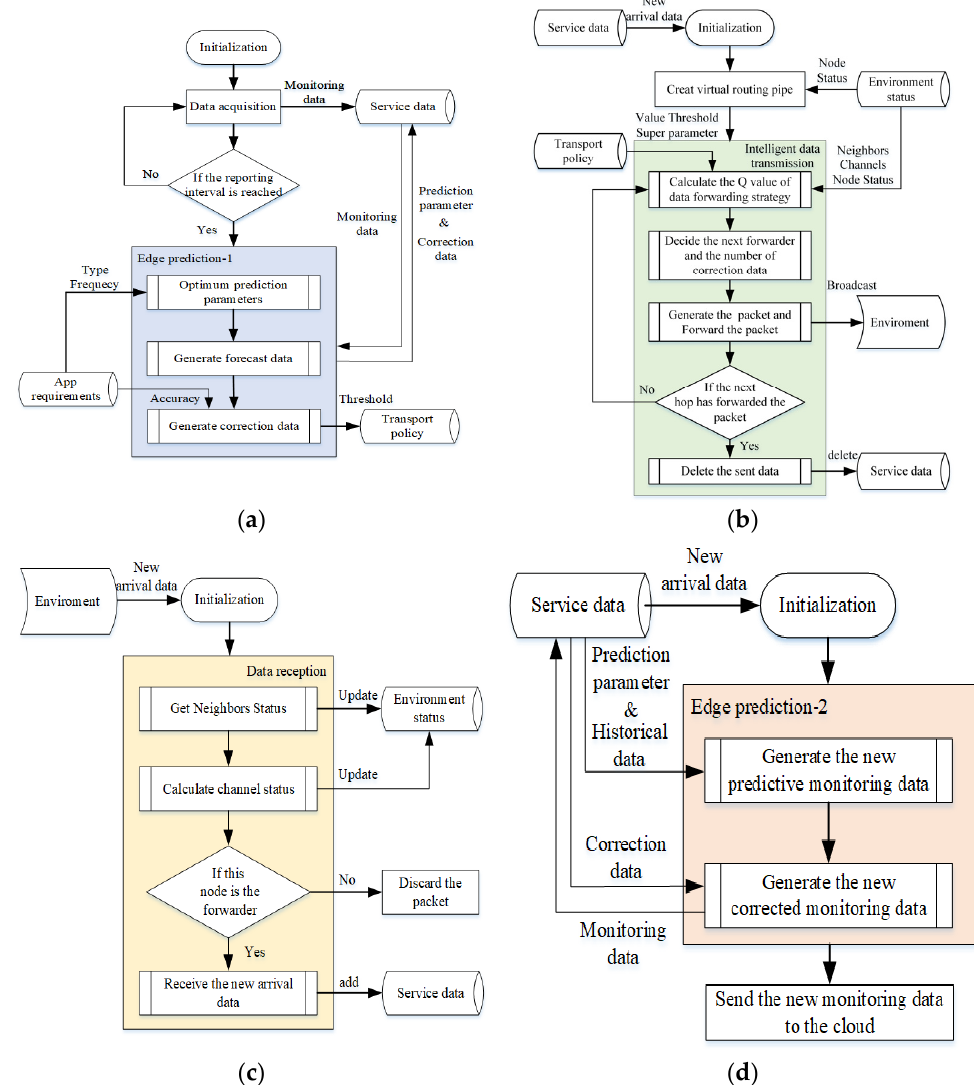
Figure 3. Operation flow of the agents: ( a ) data acquisition and edge prediction process; ( b ) data sending process; ( c ) data receiving process; ( d ) edge prediction and data recovery process.